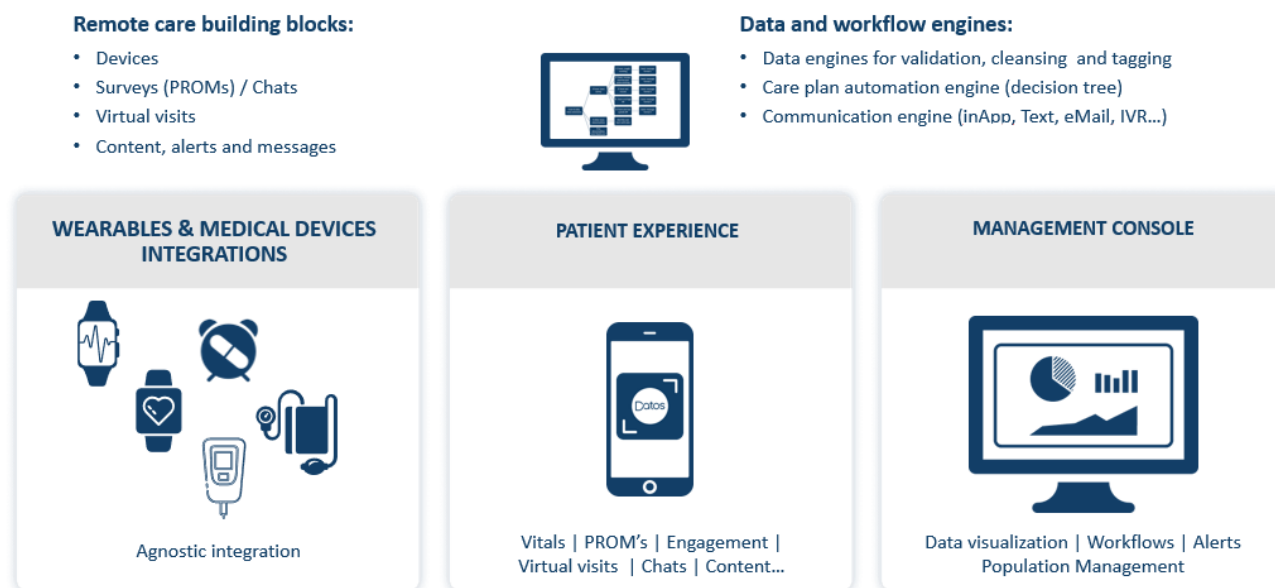
Figure 2. Description of Datos remote care automation platform used in the current study. In the pediatric rehabilitation department during the pandemic, and in order to facilitate connectivity, only the virtual video call functionality was used (no wearables/other medical devices were integrated).